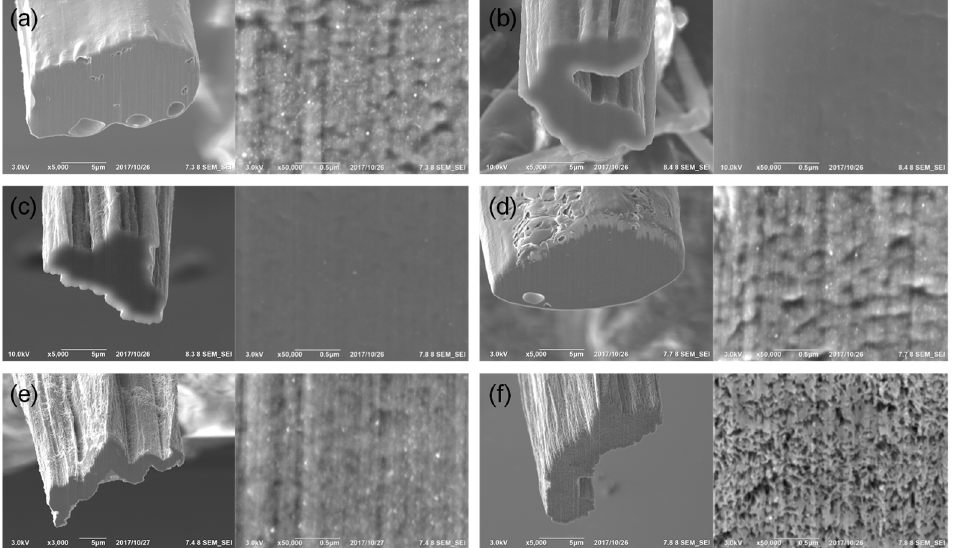
Figure 2. Cross-section images of CNTFs with infiltrated ( a ) Resin #1, ( b ) Resin #2, ( c ) Resin #3, ( d ) Resin #4, ( e ) Resin #5, and ( f ) Resin #6. The left images are low-magnification images and the right images are high-magnification images.